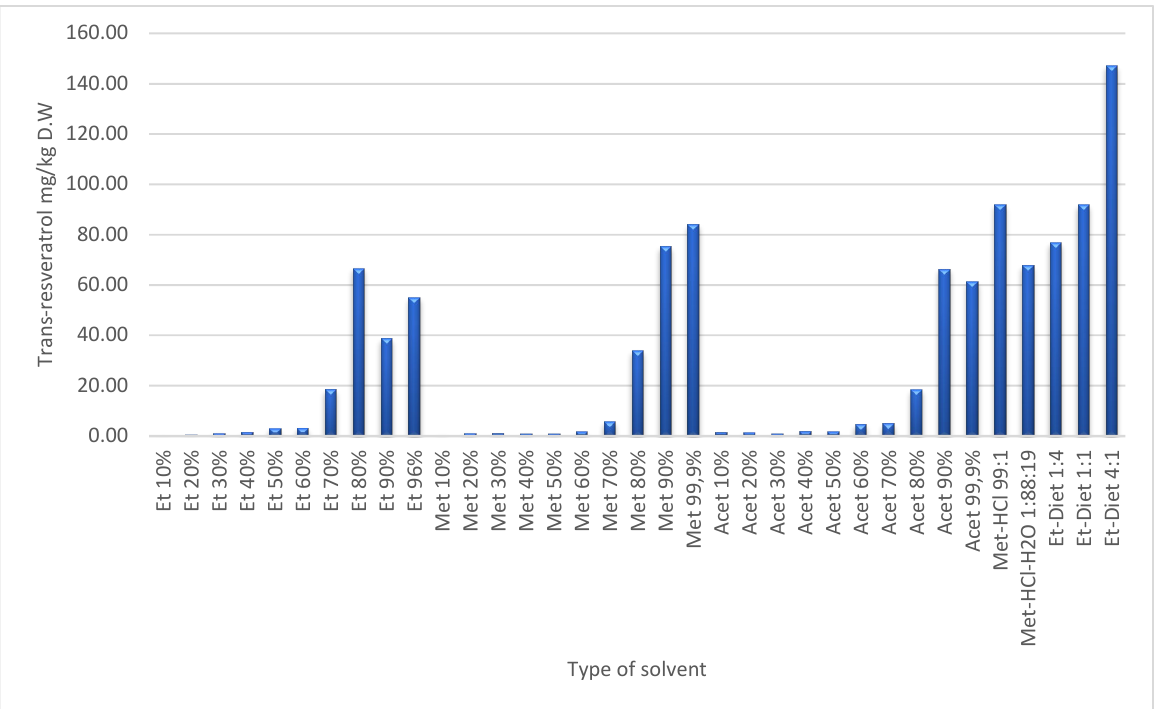
Figure 1. Extraction yield of resveratrol of different solvents from vine shoots of Feteasc ă Neagr ă variety.